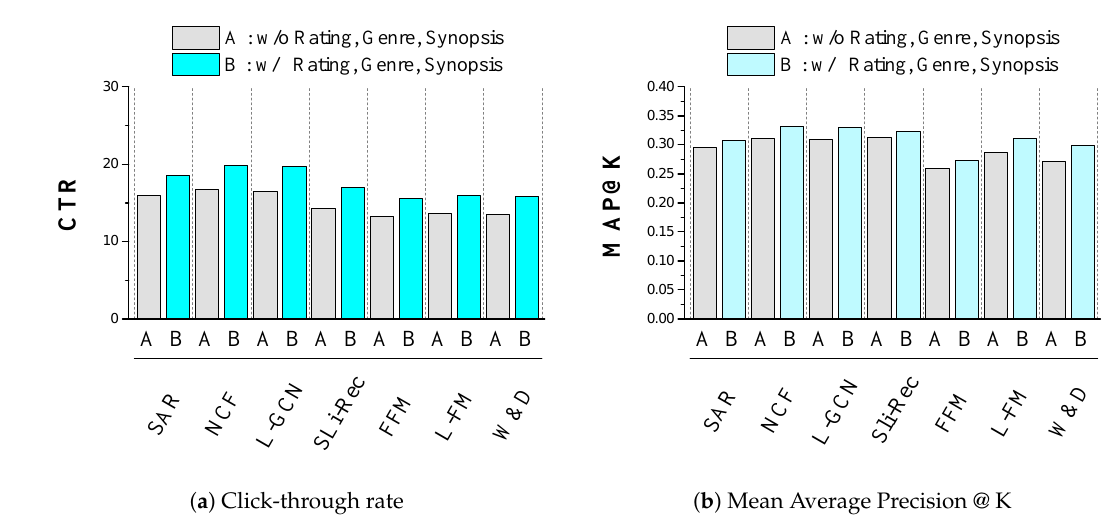
Figure 13. Visualization of A/B experiments for the aggregation of information ( Yahoo dataset).